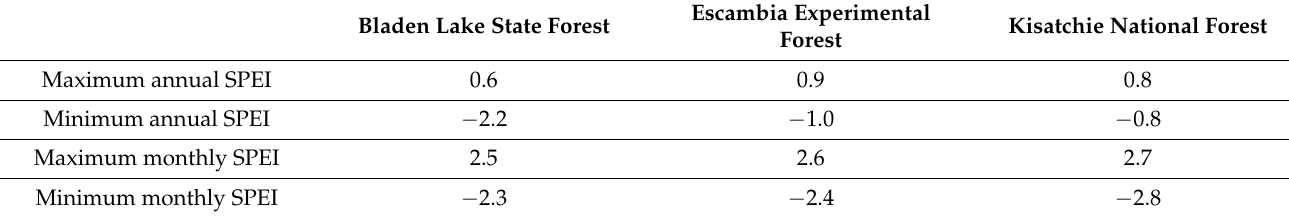
Table 3. The maximum and minimum values of SPEI at three sites.